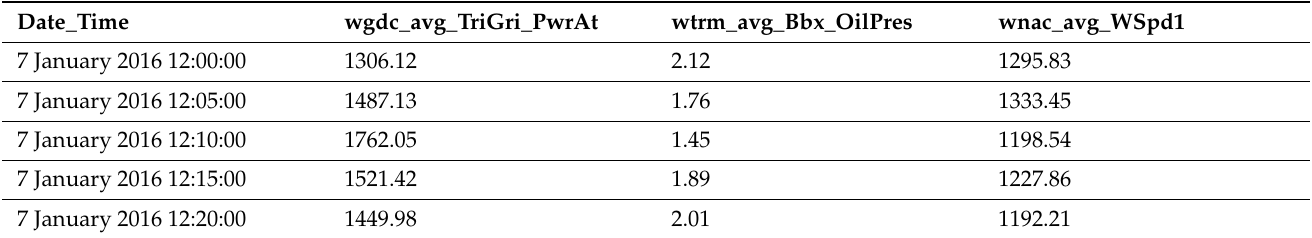
Table 2. Example of the set of data analysed. The three listed variables (in columns) are: (i) the average active power of the turbine, in W; (ii) the average oil pressure in the gearbox in Pa; and (iii) the average wind speed in m/s, respectively.